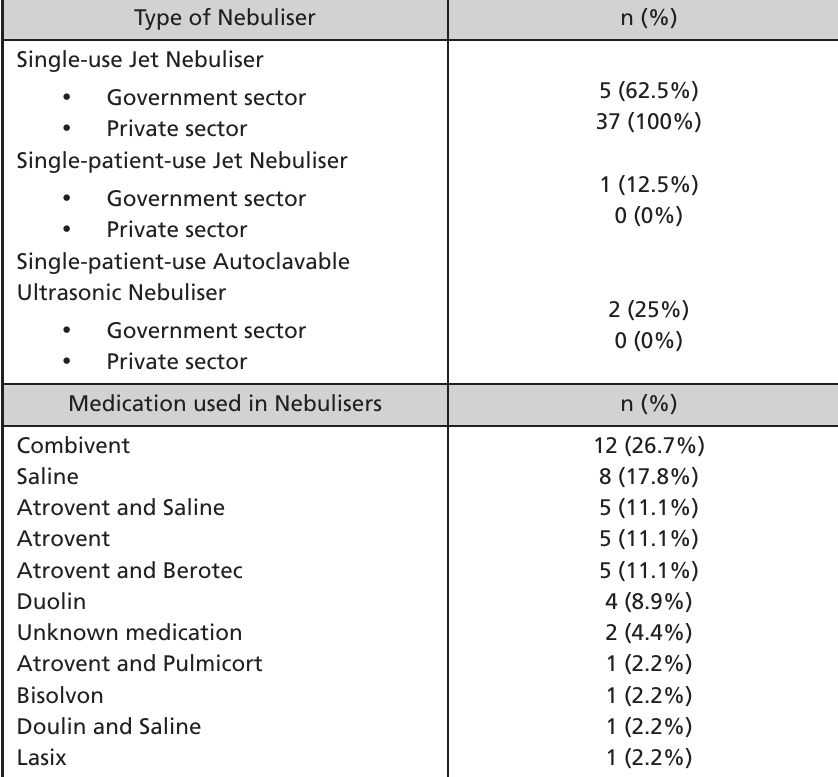
Table 2: Nebuliser Type and Medication used in Nebulisers